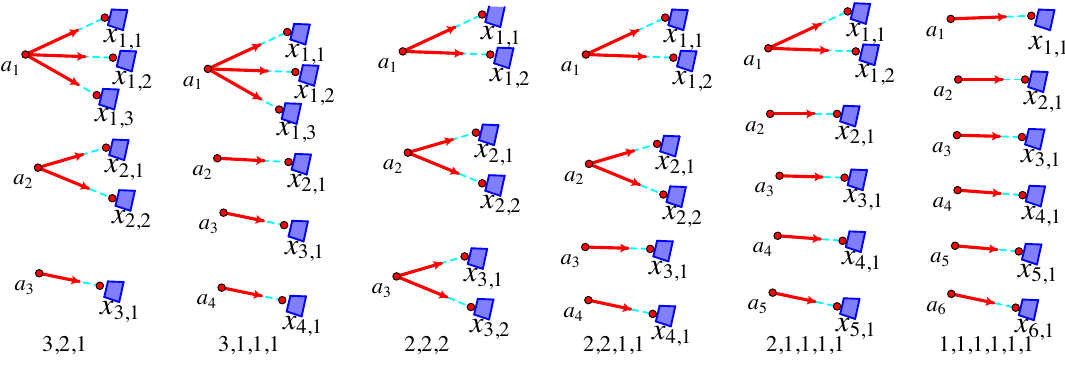
Figure 26. Possible patterns of non-degenerate tie-downs of an isostatic framework in d = 3. As the figure indicates, we can index the tie-downs by their sequence of